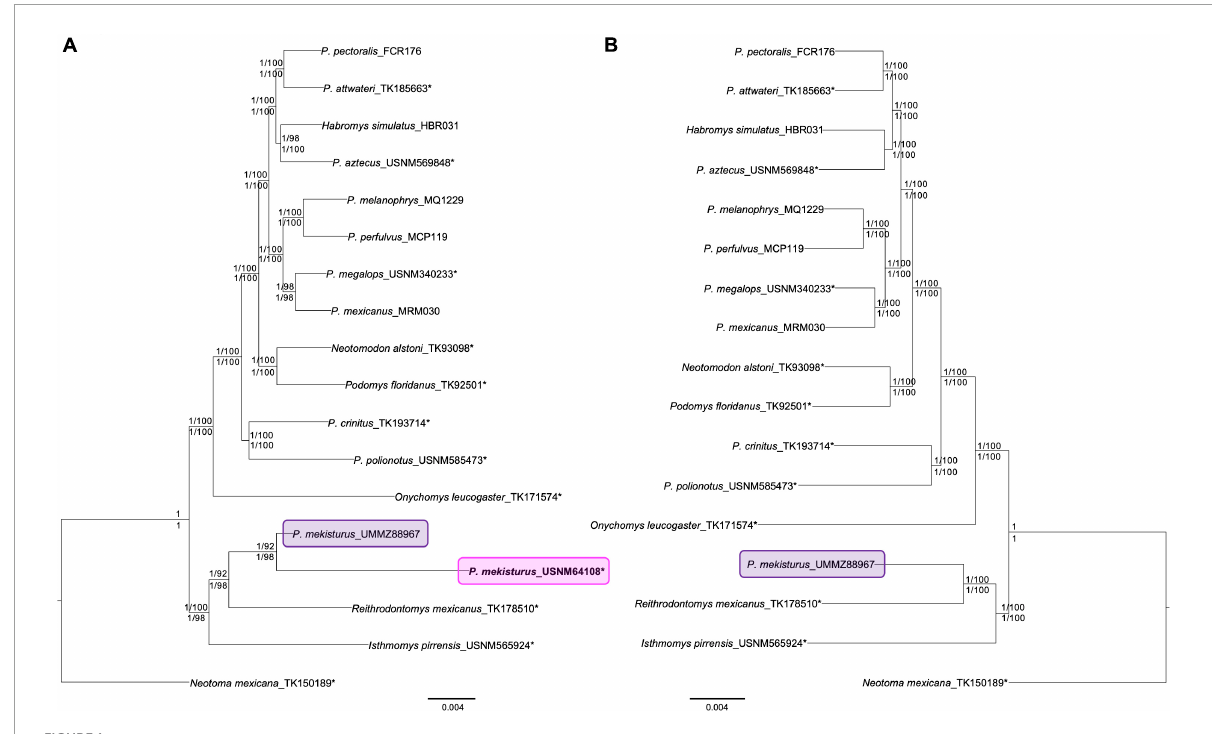
FIGURE1 Ultraconserved elements (UCE) phylogenetic trees constructed using Bayesian Inference and Maximum Likelihood with and without partitions. Trees from all analyses yielded identical topologies. Nodal support is denoted with posterior probability/bootstrap values (numbers above the branches indicate results without partitions, those below with partitions). (A) Phylogenetic tree using a complete dataset ( N = 18) based on 85 UCE loci (95% matrix) showing the phylogenetic position of the two Peromyscus mekisturus specimens. The pink block highlights the phylogenetic position of the P. mekisturus holotype collected in 1898, and the purple block shows the position of the P. mekisturus specimen collected in 1947; (B) phylogenetic tree based on 417 UCE loci (95% matrix, N = 17). Note that the removal of the holotype due to missing data (306 loci) does not change the tree topology but increases the nodal support between P. mekisturus and R. mexicanus. Asterisks* denote specimens that were sequenced from museum specimens for this